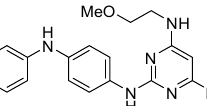
Figure 3. Structure of Aa3 .